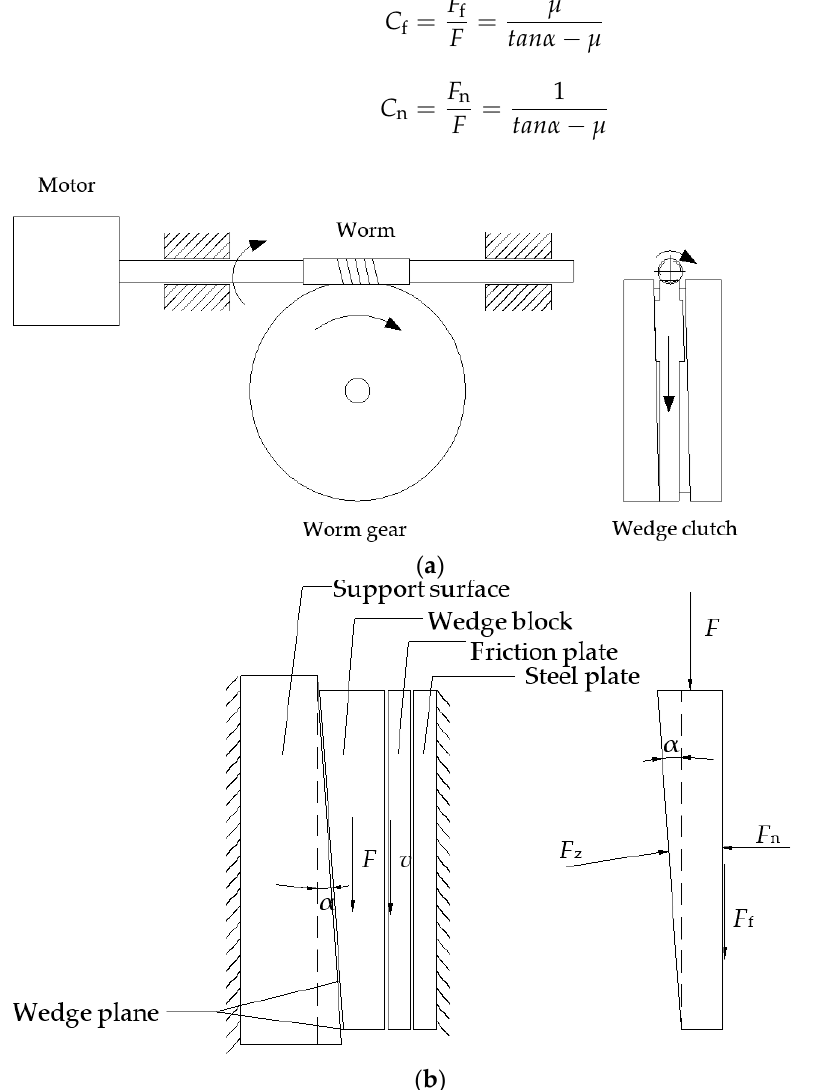
Figure 2. Electronically controlled wedge clutch system schematic. ( a ) Wedge clutch actuator schematic diagram. ( b ) Wedge clutch force schematic diagram.